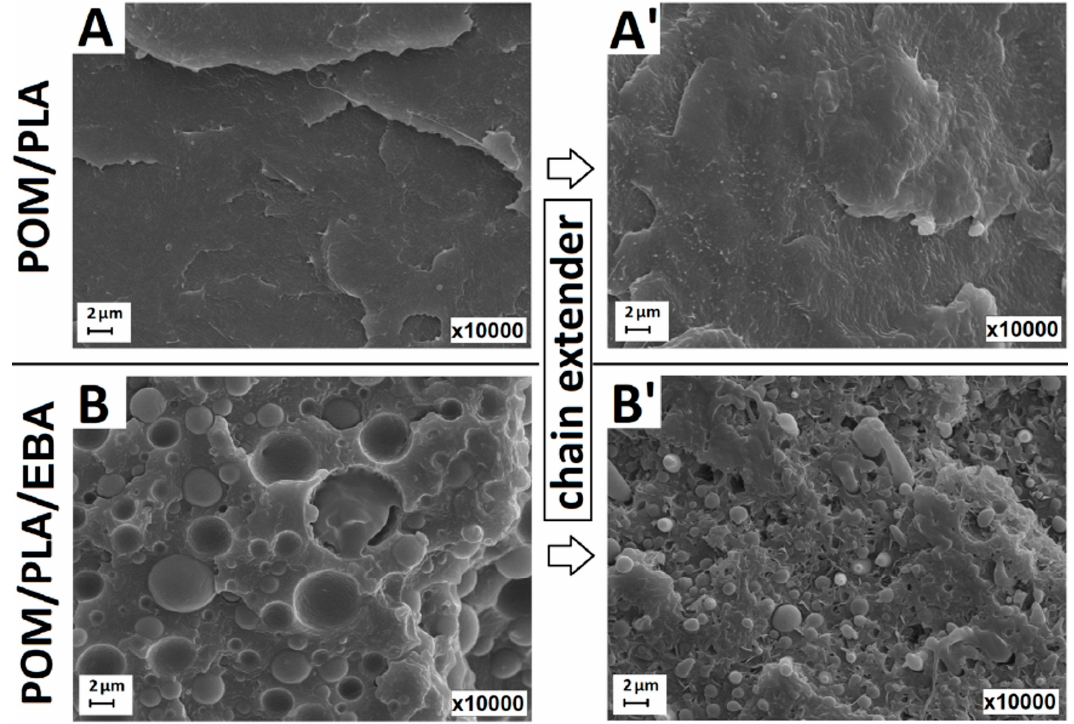
Figure 11. SEM micrographs presenting the cryo-fractured structure of the pure POM / PLA blend ( A , A’ ) and EBA-modified blends ( B , B’ ). A and B present samples without CE addition while A’ and B’ show structures following the introduction of